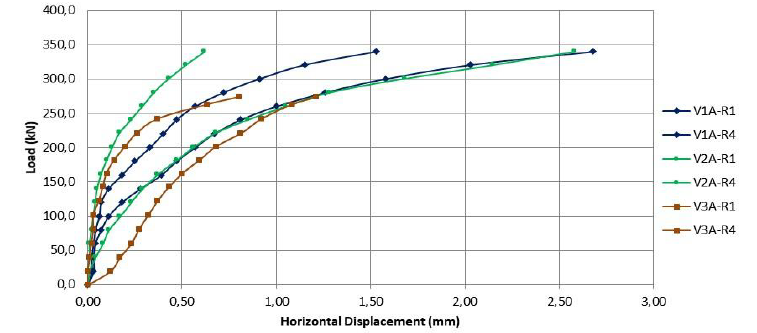
Figure 26. Comparative relative displacement curve – V1A, V2A e